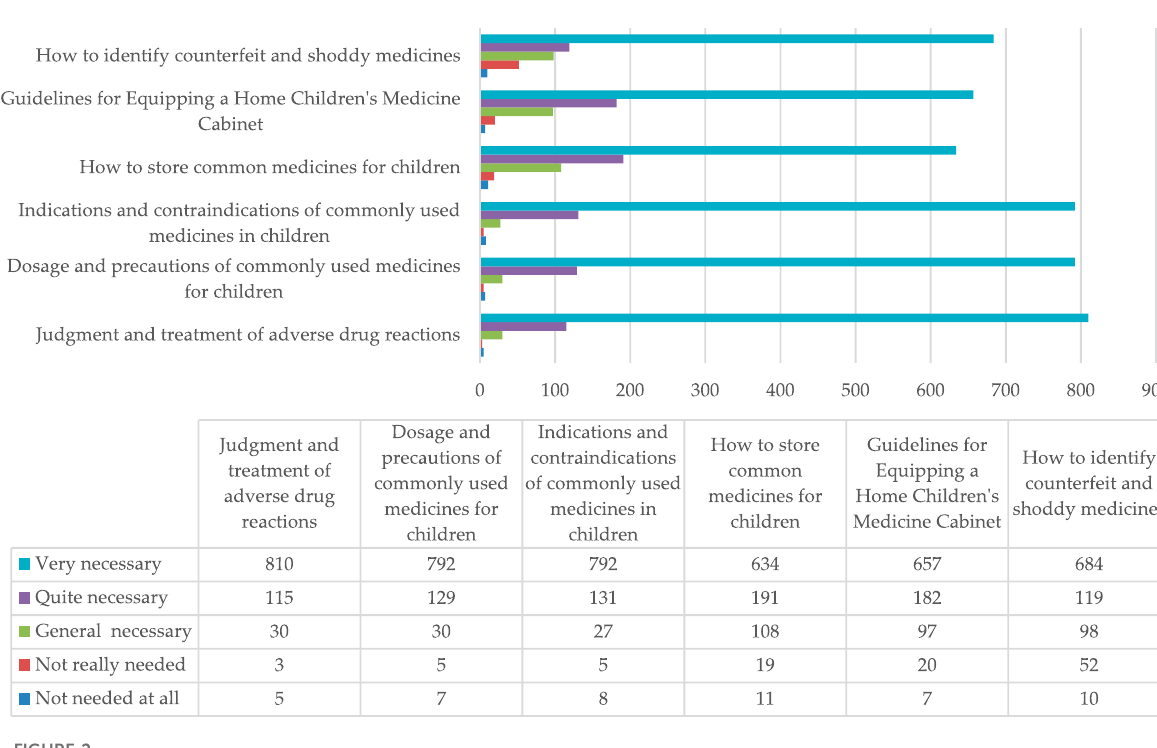
FIGURE 2 Caregivers ’ need for scienti fi c content on safe medication usage for